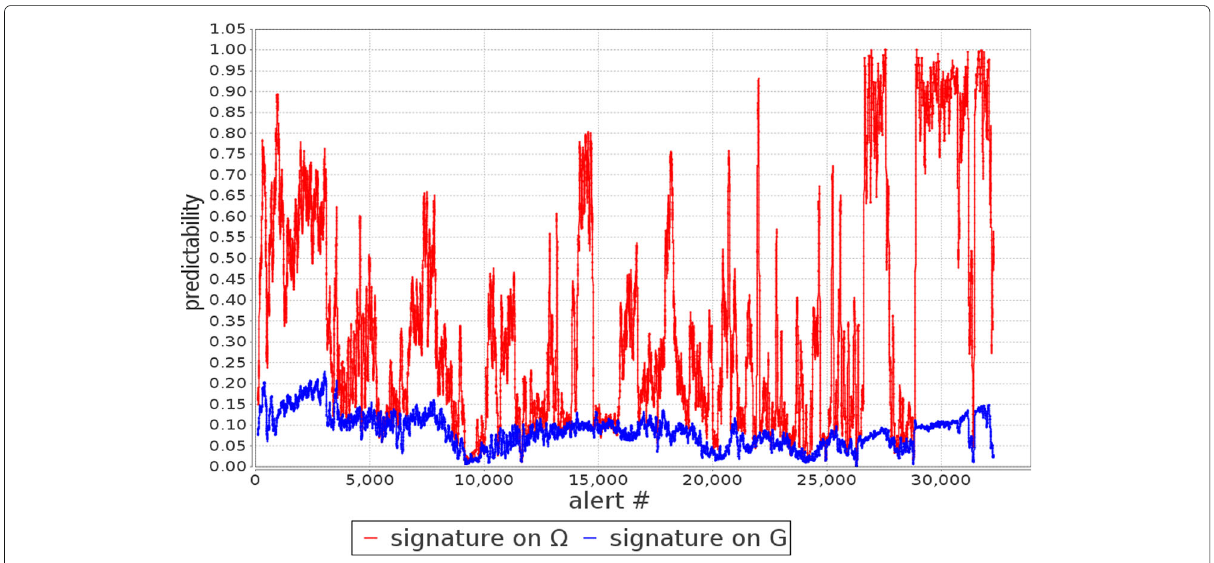
Fig. 8 The ˜ p n ((cid:2)) and ˜ p n ( G ) for alert signature as the alerts come into the system